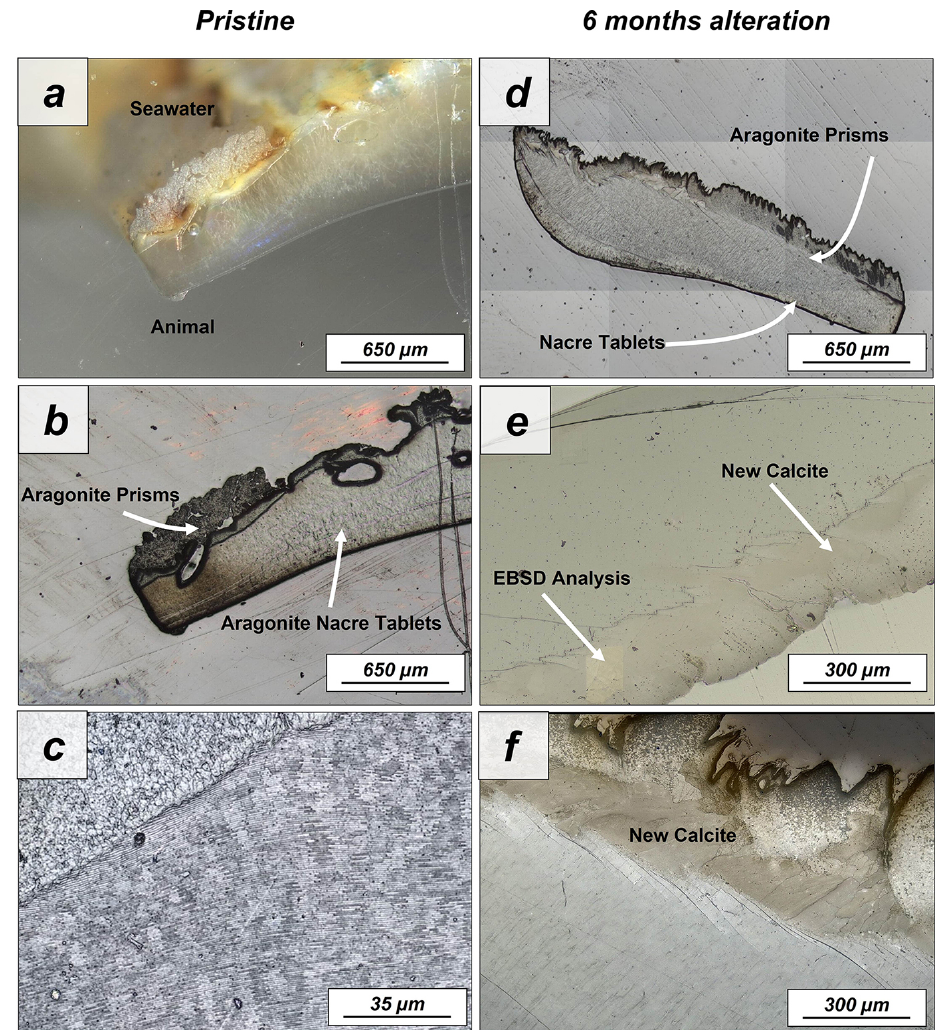
Figure A7. Laser confocal microscopy images of (a–c) pristine and (d–f) altered shells of Haliotis ovina . The shell is composed of two layers: a prismatic outer layer and a nacreous inner layer close to the animal soft tissue. While the nacreous layer shows no major structural change upon alteration, large calcite crystals can be observed in the prismatic layer after 6 months interaction with the burial fluid.